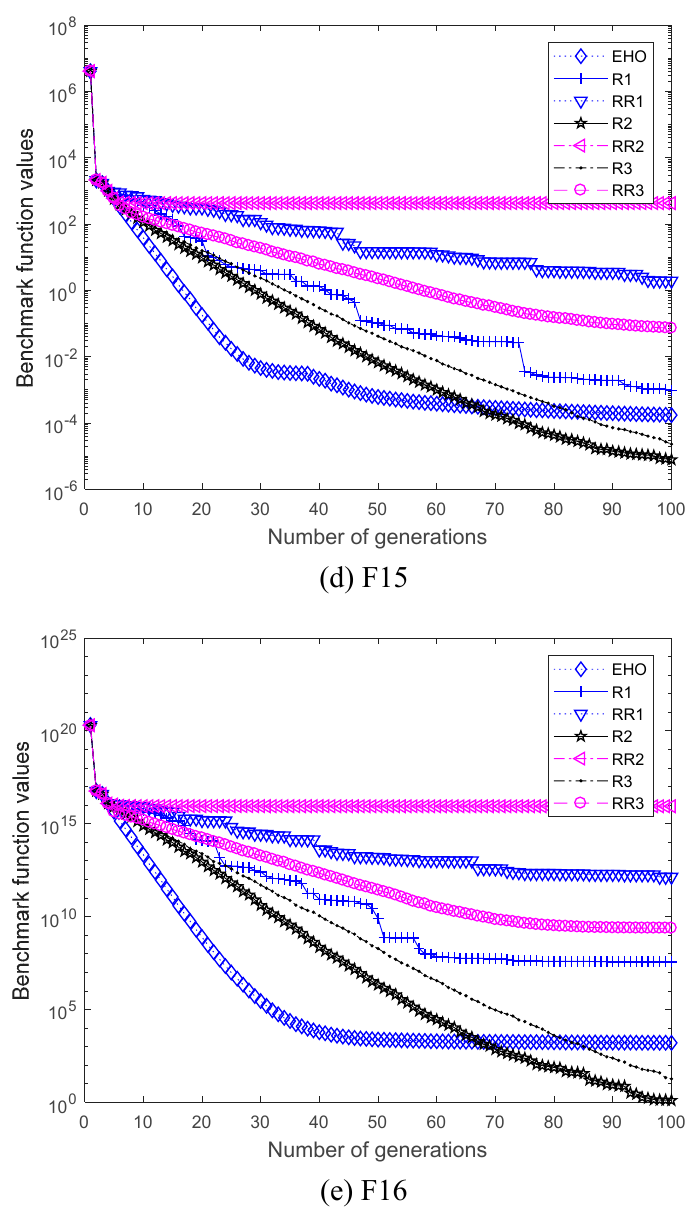
Figure 4. Optimization process of seven algorithms on five functions with D = 500.